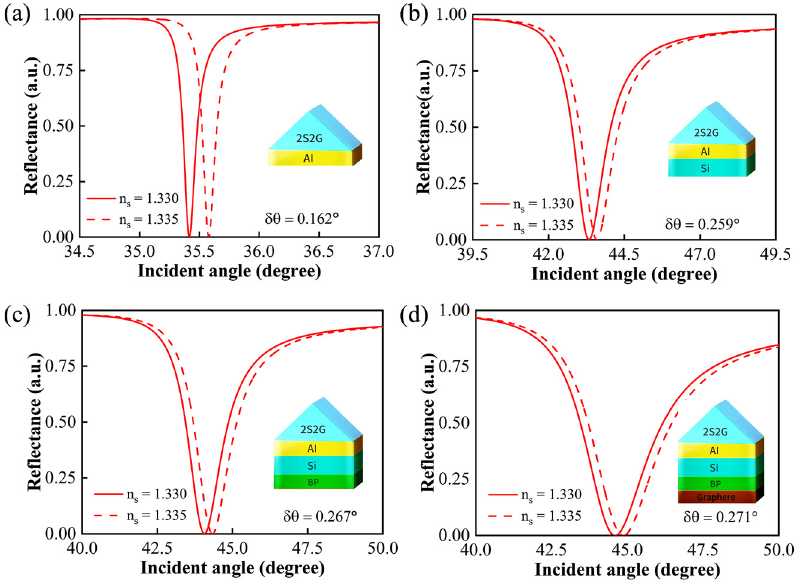
Figure2: Reflectanceofvariousstructuresas the function of incident angles. (a) Surface plasmon resonance (SPR) biosensor composed of chalcogenide (2S2G) coupling prism and aluminum (Al) film; (b) guided- wave surface plasmon resonance (GWSPR) with a thickness of 14 nm on the Al fi lm;